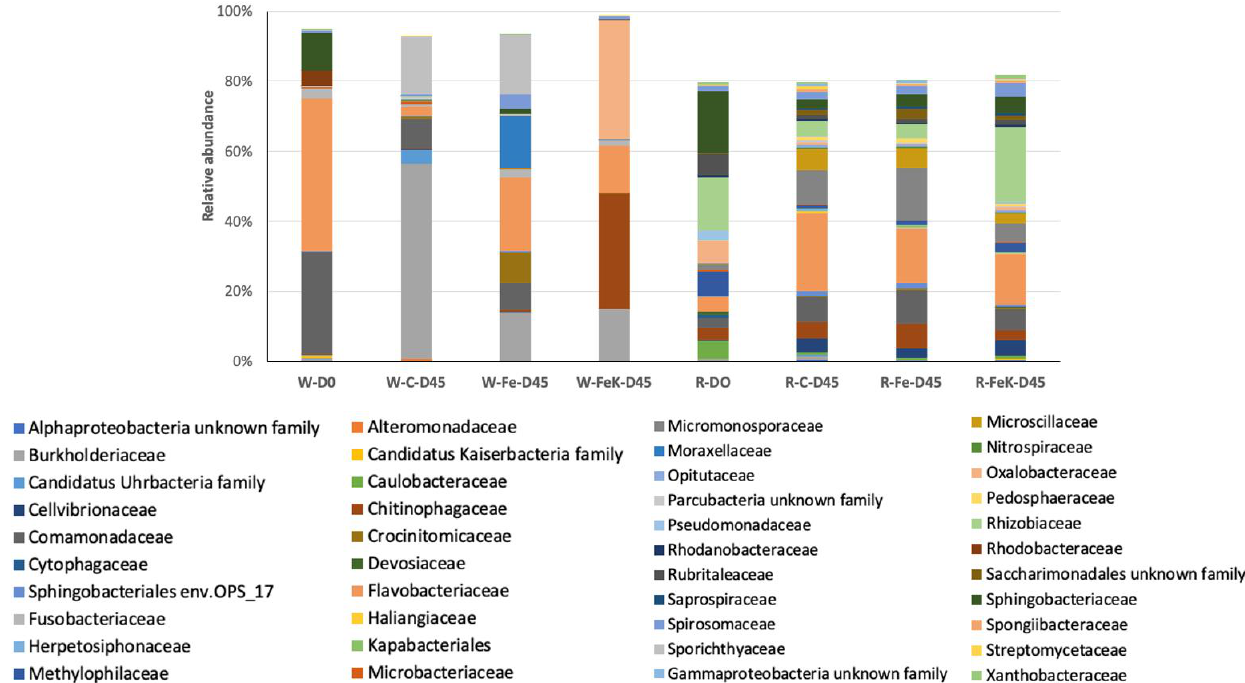
Figure 7. Clustering of the water and root bacterial community composition. W: water; R: root; C: control; Fe: iron; K: potassium; D0: the first sampling just before the commencement of the experiment; D45: the second sampling at the 45th day of the experiment.